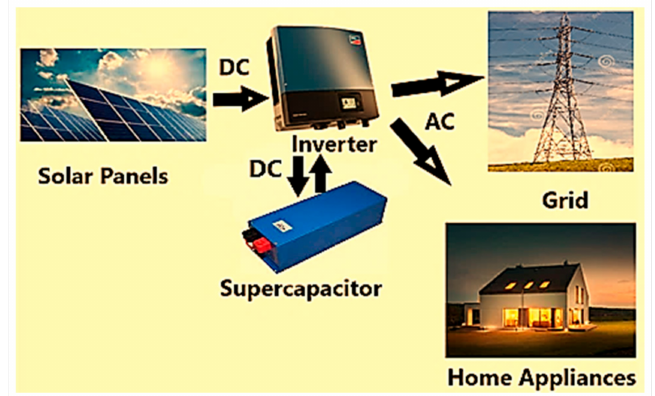
Figure 2. The basic components of a PV